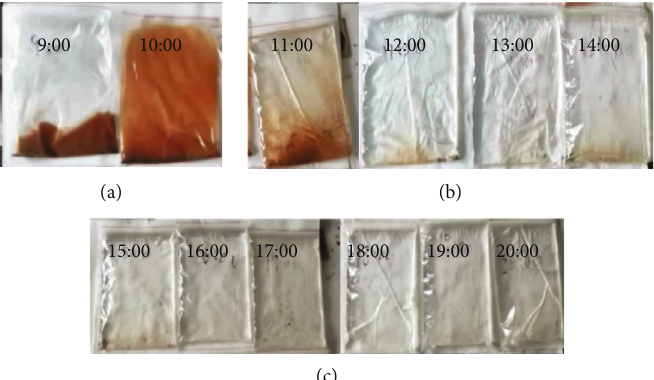
Figure 7: Image of slurry mixture exuded by the fi ller under heavy rain: (a) rapid loss of fi ne particles stage; (b) skeleton remodeling stage; (c) relative stability